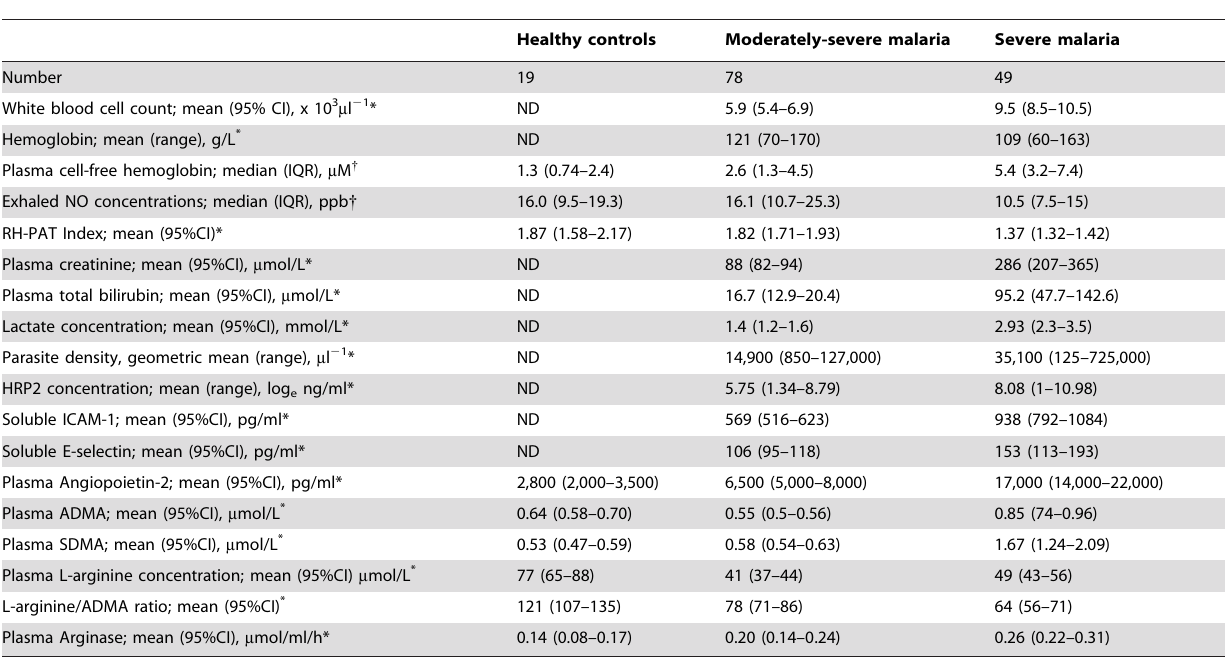
Table 2. Baseline Laboratory and Physiological Measurements According to Clinical